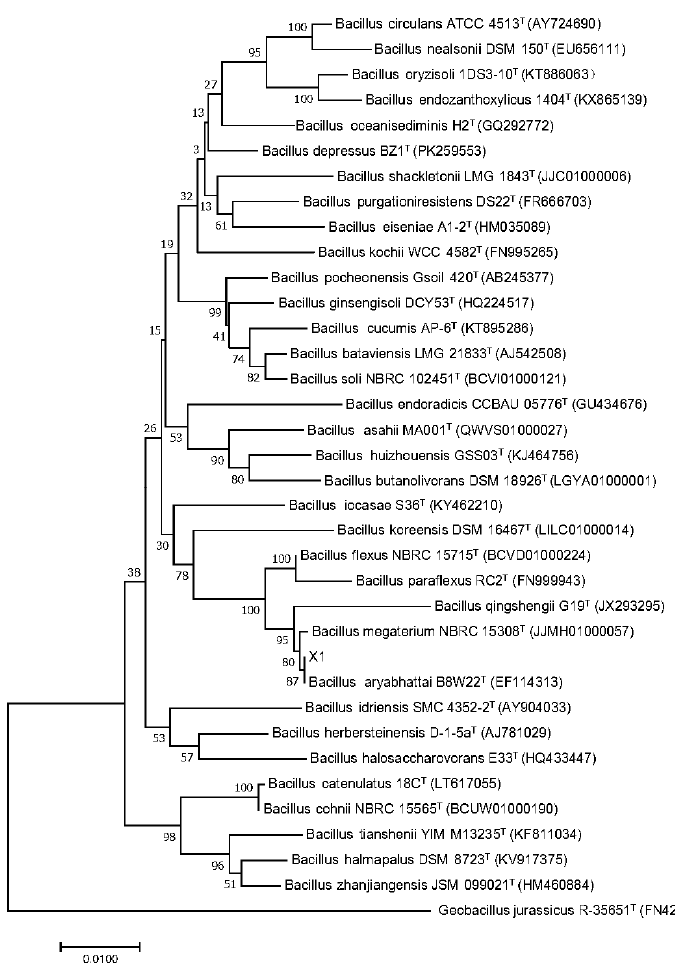
Figure 2. Phylogenetic tree of X1 16S rRNA with other Bacillus strains.